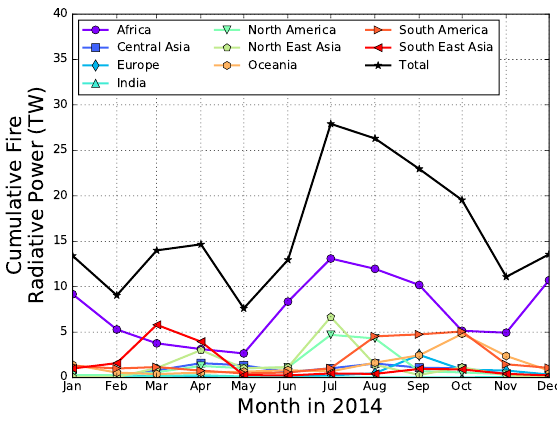
Figure 5. Time series of the MODIS cumulative fire radiative power over different biomass burning source